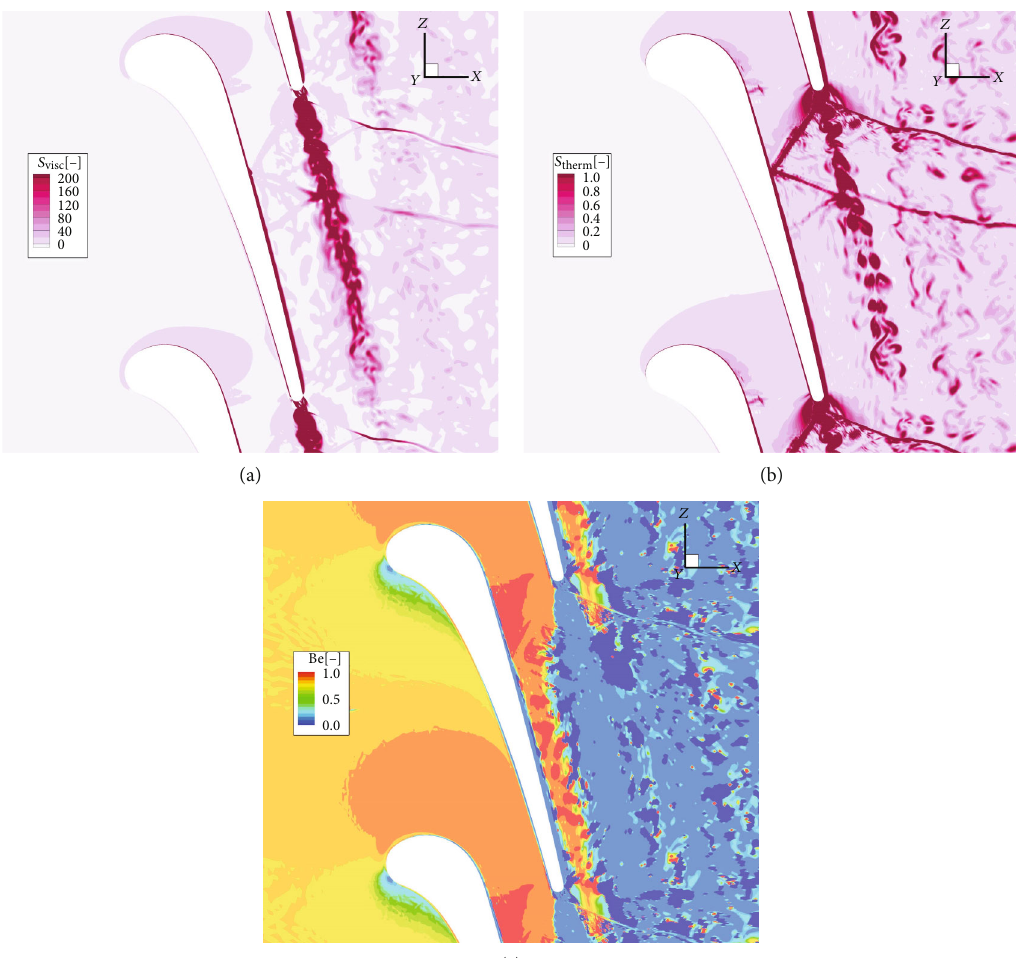
= 1 : 16 ): (a) viscous entropy generation rate; (b) thermal ex